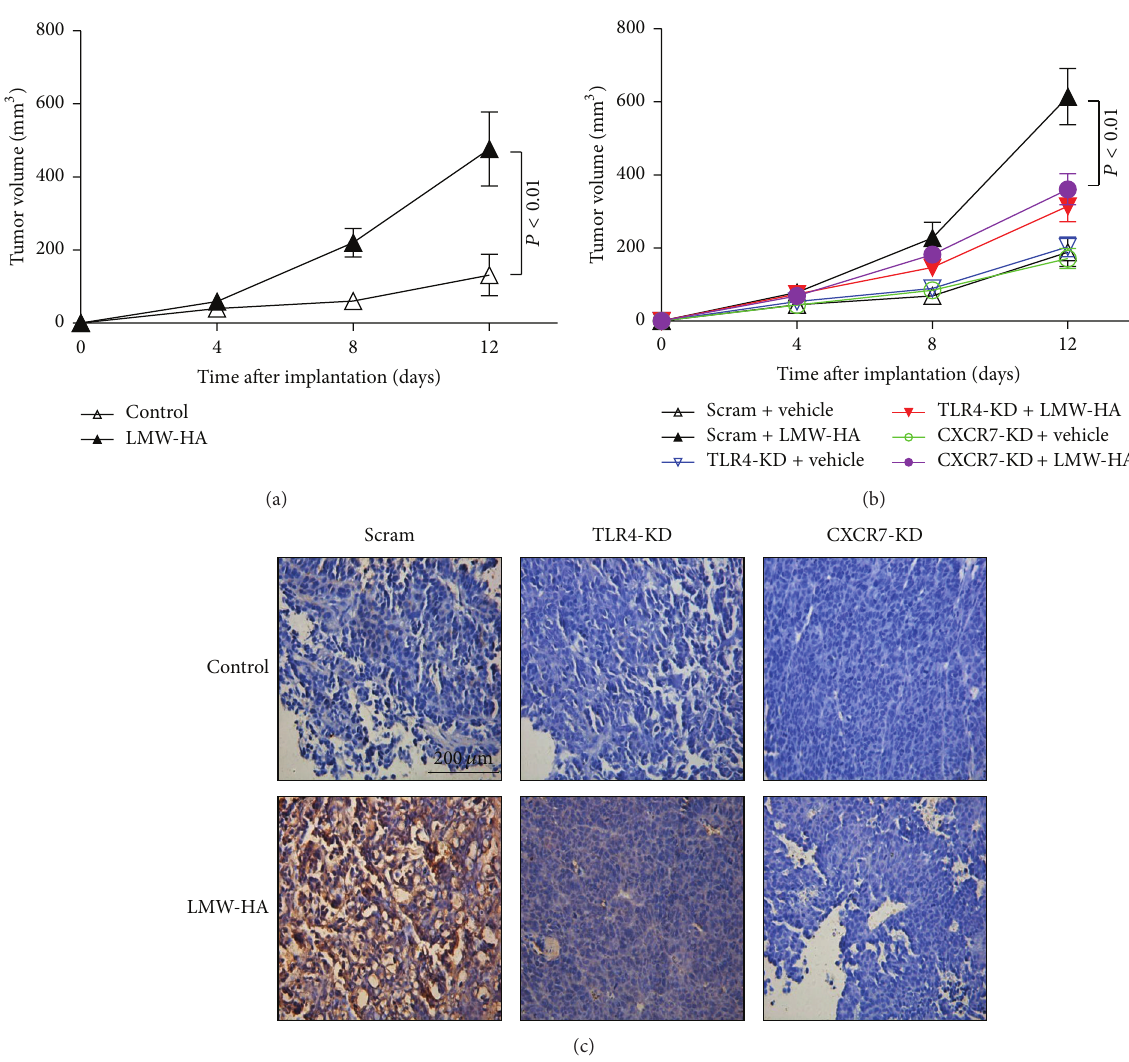
Figure 4: LMW-HA enhances the tumorigenicity of W3 cell line via TLR4/CXCR7 pathway. (a) W3 cells (6 × 10 6 cell/mouse) were injected subcutaneously into the flanks of nude mice, and mice were intratumorally injected with LMW-HA (400 𝜇 g/kg) or the same volume of DMSO every other day. Tumors were measured with a caliper every fourth day. When tumor maximum diameter reached about 1.0cm, mice were euthanized and tumors were removed and weighed. The volumes of the tumor masses formed in LMW-HA treatment groups and control treatment groups were determined. (b) Scram-W3 cells, TLR4-KD W3 cells, and CXCR7-KD W3 cells were injected subcutaneously into the flanks of nude mice, and mice were intratumorally injected with LMW-HA (400 𝜇 g/kg) or the same volume of DMSO every other day. Tumor volumes were determined and shown. (c) CXCR7 expression of tumors was analyzed by immunohistochemistry (original magnification 400 × ). These results were representative of three independent experiments.